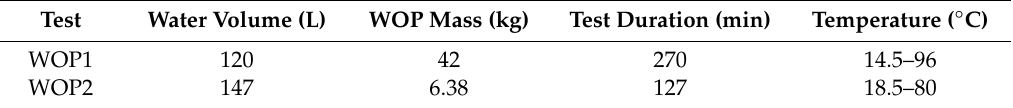
Table 1. Basic features of the waste orange peel (WOP) extraction tests. The WOP mass is expressed in kg of fresh